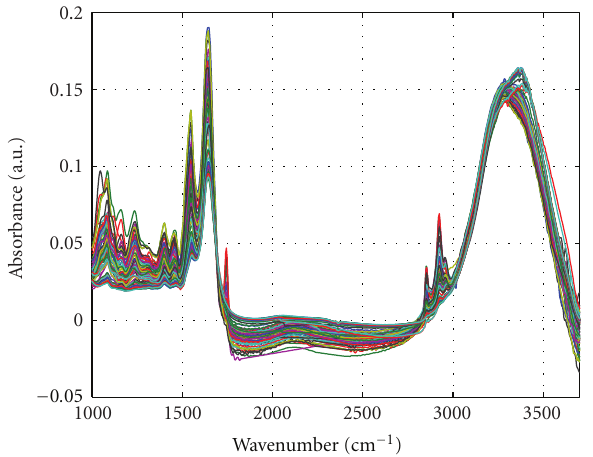
Figure 2: Preprocessed spectra with smoothing and normalization (1000–1766 cm − 1 , 2731–3695 cm − 1 ).